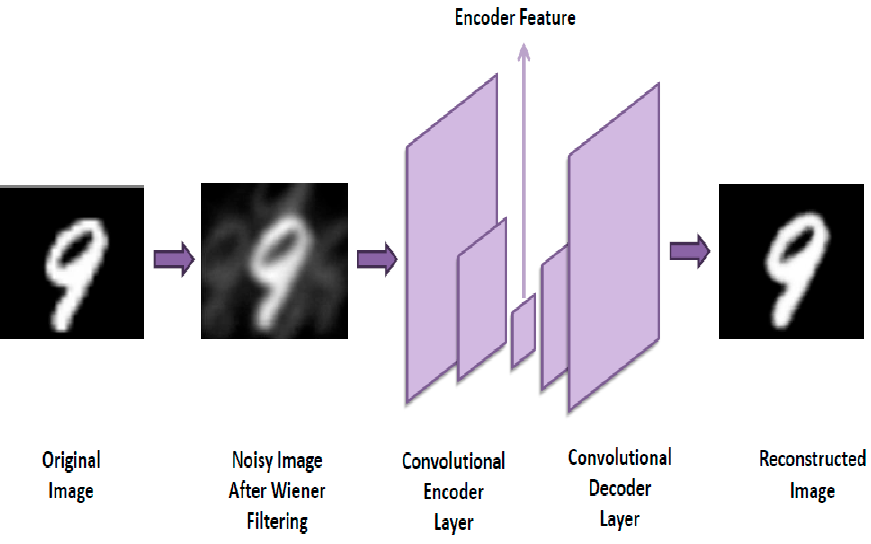
Figure 3. The structure of the proposed method.